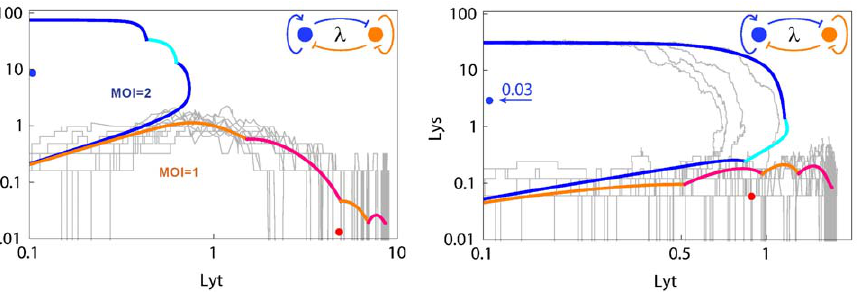
Figure 3. Trajectories of Lys and Lyt concentrations for two-protein networks. The left panel shows a rare two-protein network performing the decision task in the presence of noise. The right panel shows a network that performs the deterministic task but fails in the presence of noise. Lyt and Lys concentrations are given in units of each protein’s binding constant for regulation of the opposing protein. Red-orange trajectories depict deterministic simulations of MOI=1 infections, leading to lysis. Blue-cyan trajectories depict deterministic simulations of MOI=2 infections, leading to lysogeny. The color of the trace changes at each genome replication time. Grey trajectories are 10 examples of standard stochastic simulations of MOI=1 infections. Dots show the N=1 steady states (single copy immune and anti-immune states).